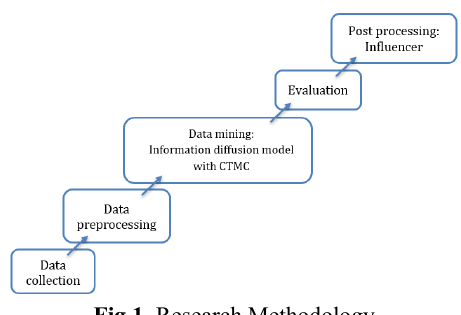
Fig.1. Research Methodology